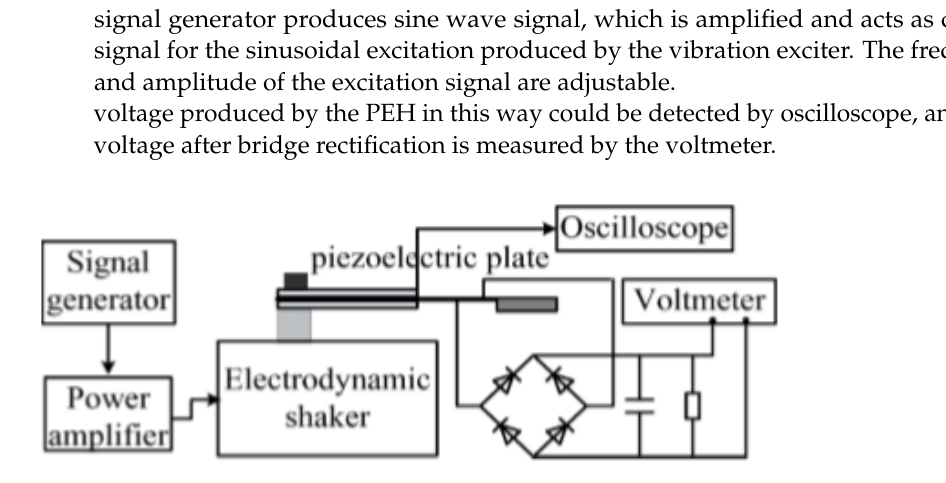
Figure 8. Experiment device diagram for piezoelectric energy harvester (PEH), as used in